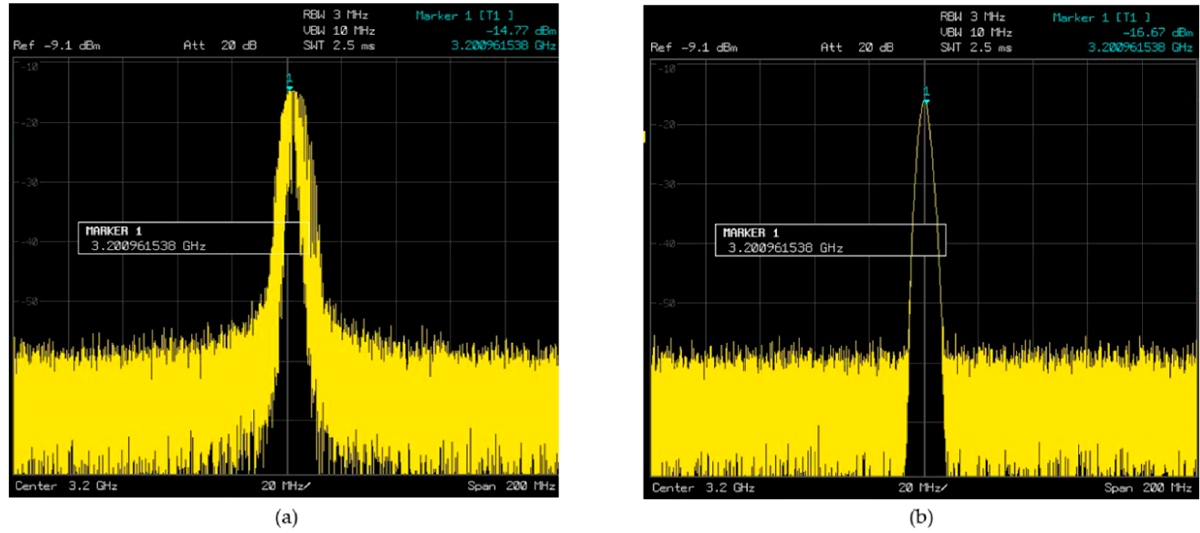
Figure 9. Comparison of the PLL spectrum ( a ) without injection locking and ( b ) with injection locking.